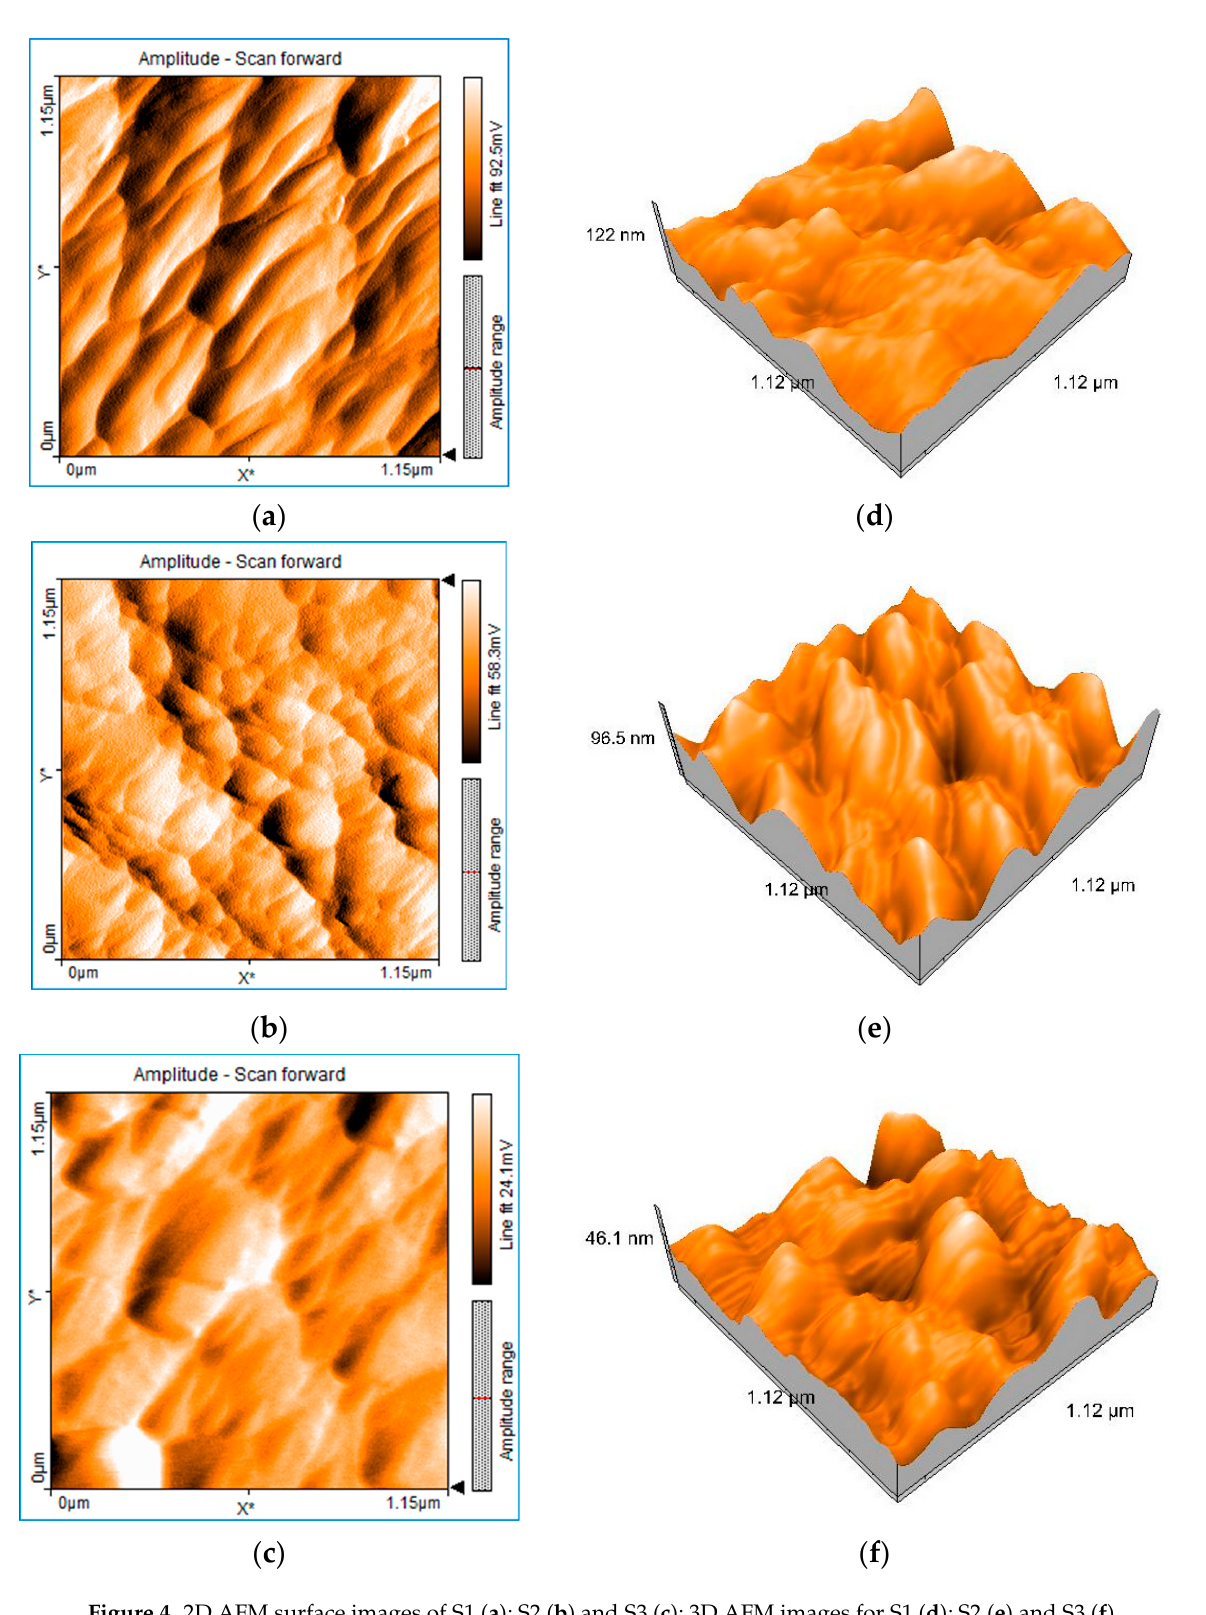
Figure 4. 2D AFM surface images of S1 ( a ); S2 ( b ) and S3 ( c ); 3D AFM images for S1 ( d ); S2 ( e ) and S3 ( f ).